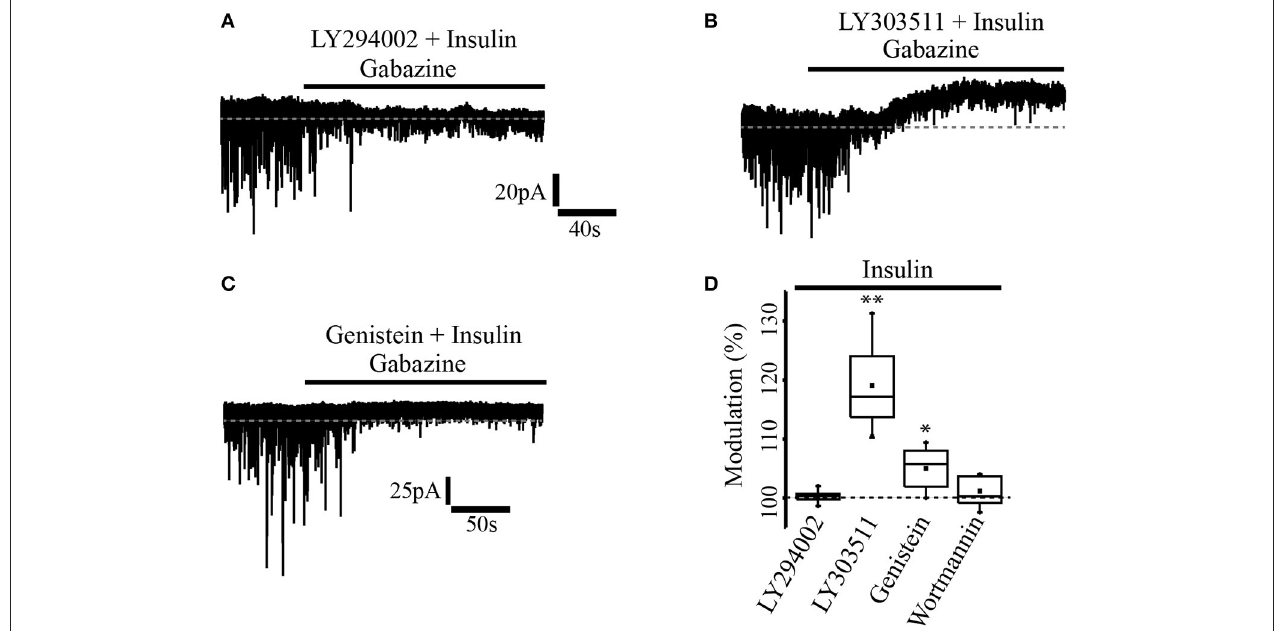
FIGURE 2 | Insulin effect was mediated through PI3K/Akt pathway. (A) In slices previously incubated with the PI3K inhibitor, LY294002 (1 µ M) and insulin, gabazine had no effect on the tonic current. (B) The incubation with insulin and the inactive analog of the PI3K inhibitor, LY303511 (5 µ M) failed to prevent the shift of the tonic current induced by gabazine. (C) In slices incubated with insulin and genistein (50 µ M), a tyrosine kinase inhibitor, gabazine produced a small effect on the tonic current. (D) Box plot summary showing the normalized shift produced by gabazine for LY294002 ( n = 5), LY303511 ( n = 7), genestein ( n = 6), and wortmannin (200nM, n = 5) * p < 0.05, ** p <